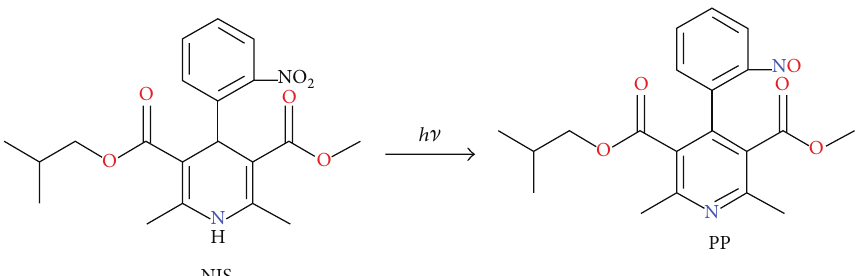
Scheme 1: Nisoldipine (NIS) unimolecular and light induced